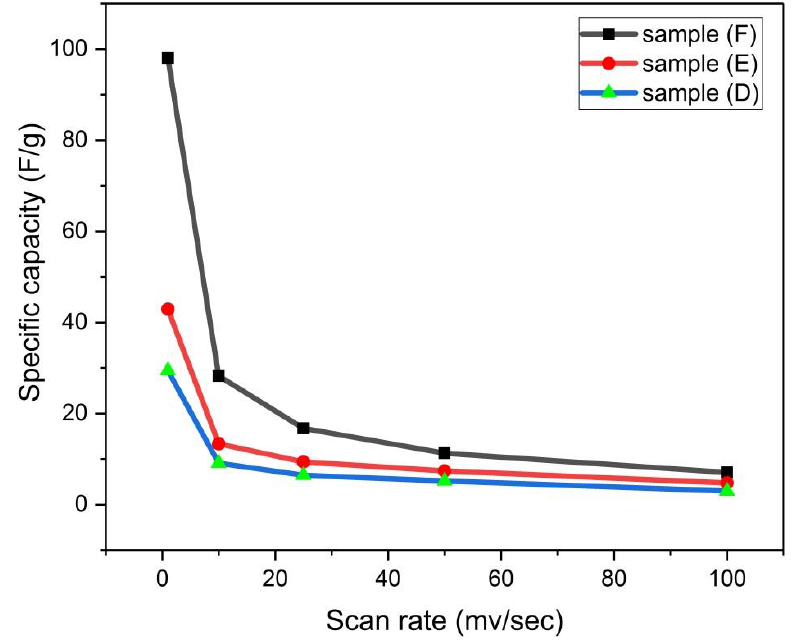
Figure 22. Variation of specific capacity with scan rate for samples (D, E, and F).